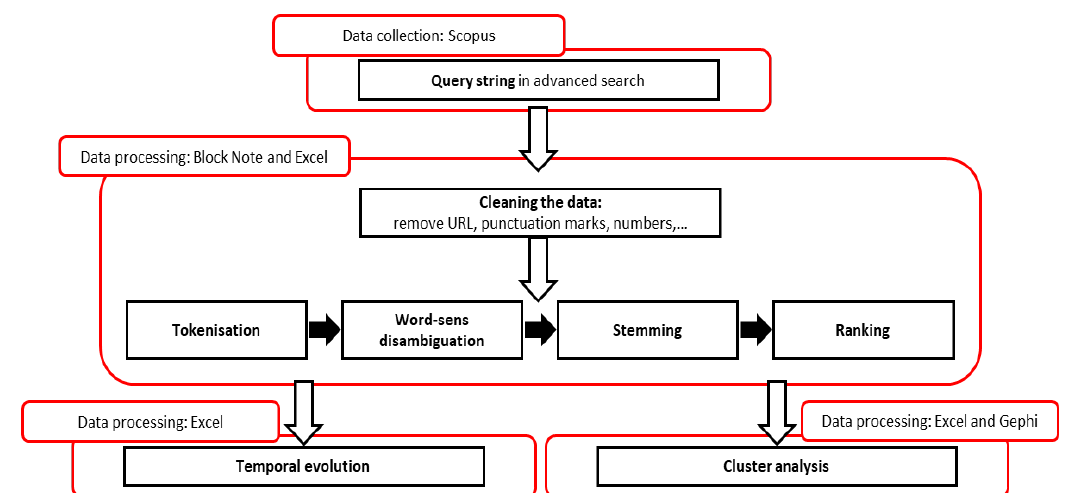
Figure 1. The conceptual flux of the analysis: model and used software.